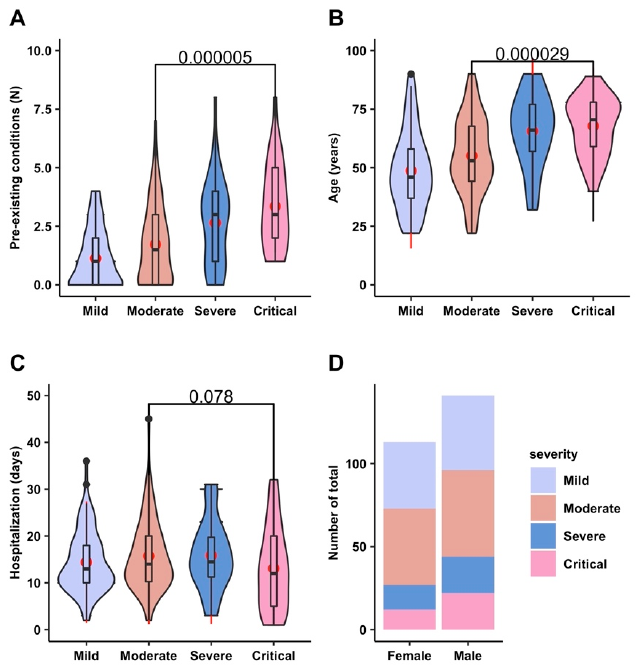
Figure 2. Characteristics of our group of COVID-19 patients. Distribution of preexisting conditions ( A ), age ( B ), and hospitalization days ( C ) in disease severity groups. Percentages of disease severity in female and male patients ( D ). Data are presented as violin plots with medians ( A – C ). The baseline laboratory tests on admission of patients with COVID-19 stratified by severity groups (mild, moderate, severe, and critical) are presented in Table 2. Patients in severe and critical groups presented significantly elevated values ( p < 0.0001) of WBC, LYM, PLT, NEU, NLR, PLR, SII, D-dimer, CRP, LDH, BUN, and ferritin as compared to those in mild and moderate severity groups. Specifically, our results have shown that higher values of these laboratory parameters were strongly associated with progression to severe forms, while no significant difference was observed between severe and critical groups, as depicted in the comparative boxplots representing the median la- boratory parameters levels at admission stratified according to disease severity groups, Figure 3.